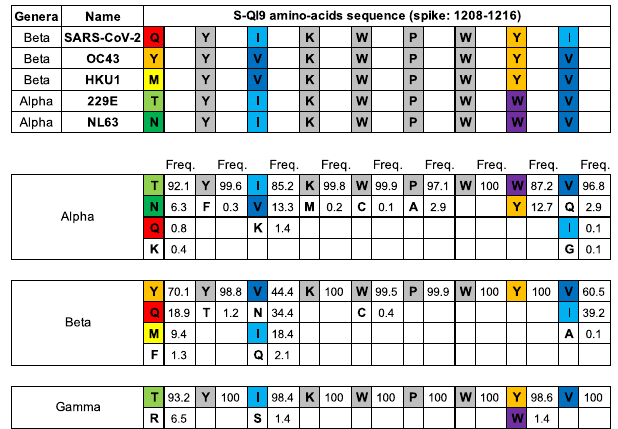
Fig. 8 | Frequency ofamino-acid residueswithin S-QI9 epitopes fromthe three genera of coronaviruses. The upper panel shows the homology of the reported sequence in the S-QI9 epitope region of SARS-CoV-2 compared with that in four seasonal human coronaviruses (OC43, HKU1, 229E, and NL63). Identical residues are color-coded in gray. The lower panel shows the frequency of amino acid var- iations in alpha-, beta-, and gamma-coronavirus sequences in the S-QI9 epitope region (approximately 2600, 1600, and 630 variations, respectively). These fre- quencies were calculated using the sequences that were submitted to the NCBI Virus database (https://www.ncbi.nlm.nih.gov/labs/virus/vssi/#/) as spike glyco- protein or spike protein from alpha- (taxid: 693996), beta- (taxid: 694002),